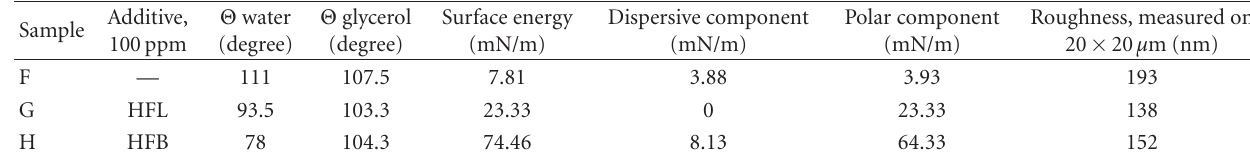
Table 3: Contact angles and surface energies measured for samples F, G, and H. Additive, Sample